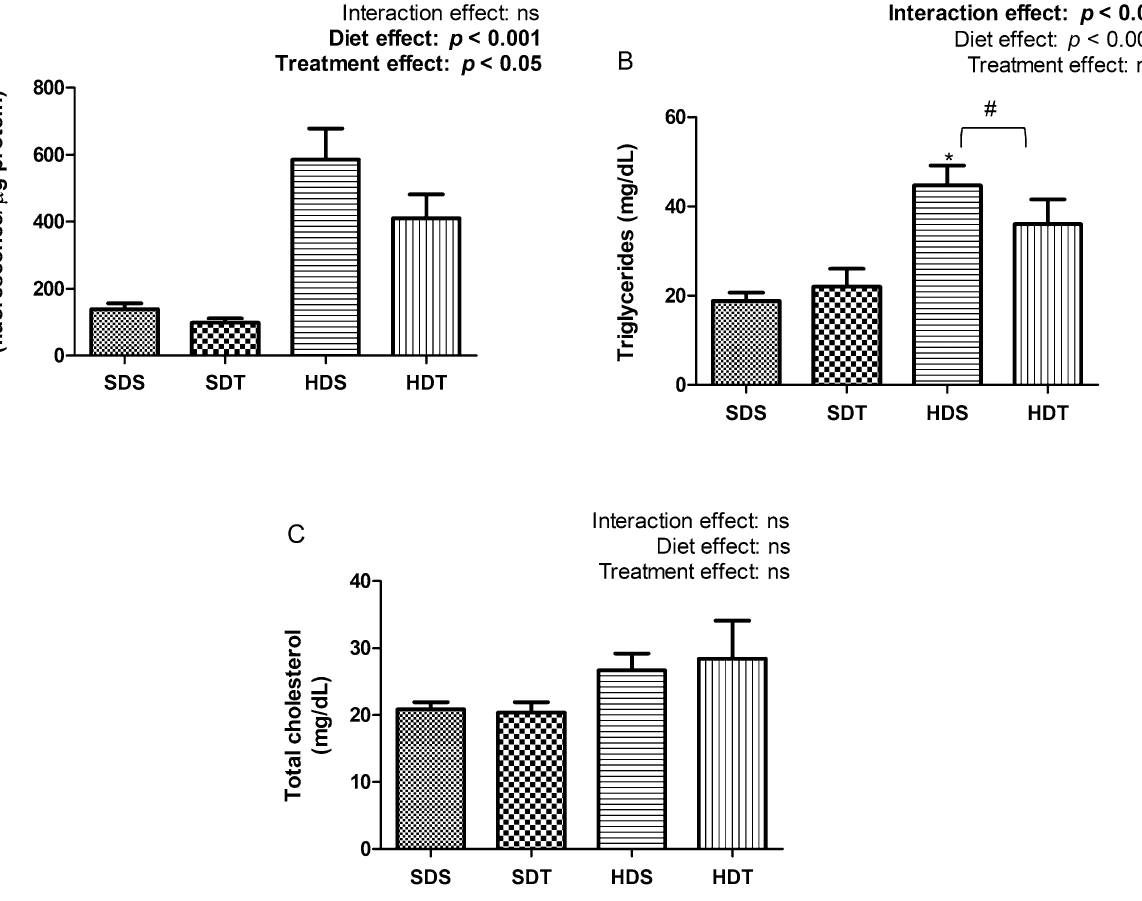
Figure 3. Quantitative analysis of liver fat deposition. ( A ) Total lipid accumulation (fluorescence/μg protein), ( B ) triglyceride (mg/dL) and ( C ) total cholesterol (mg/dL). Data expressed as mean ± SEM (n = 10/group). SDS standard diet plus sham tDCS treatment, SDT standard diet plus tDCS treatment, HDS hypercaloric diet plus sham tDCS treatment, HDT hypercaloric diet plus tDCS treatment. *Significant difference between HDS and SDS groups ( p < 0.001). # Significant difference between HDS and HDT groups ( p <